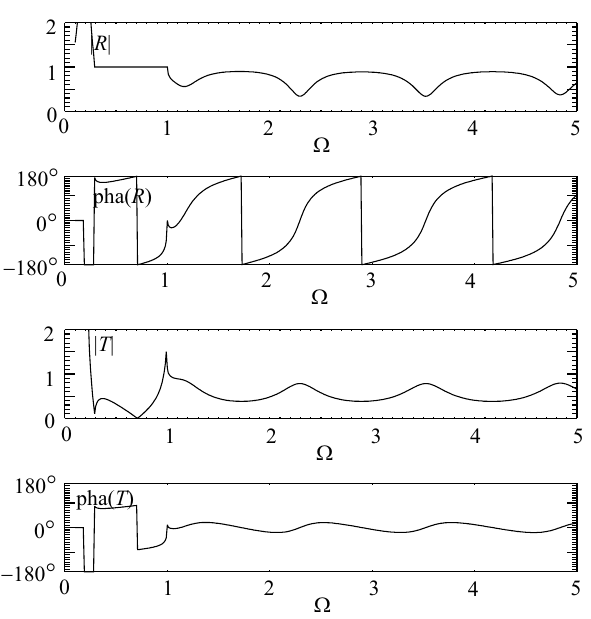
Fig. 5. Amplitude and phase of the reflection and transmission coef- ficients when the effect of the resonance is included. ρ 0 , 2 = 0 . 1 ρ 0 , 1 , Fig. 3. Computation of fields in the k z = 3 /aL 0 , k y = 3 /aL 0 , V/V A, 0 = neighbourhood of a turning point and a field line resonance (see text for expla-